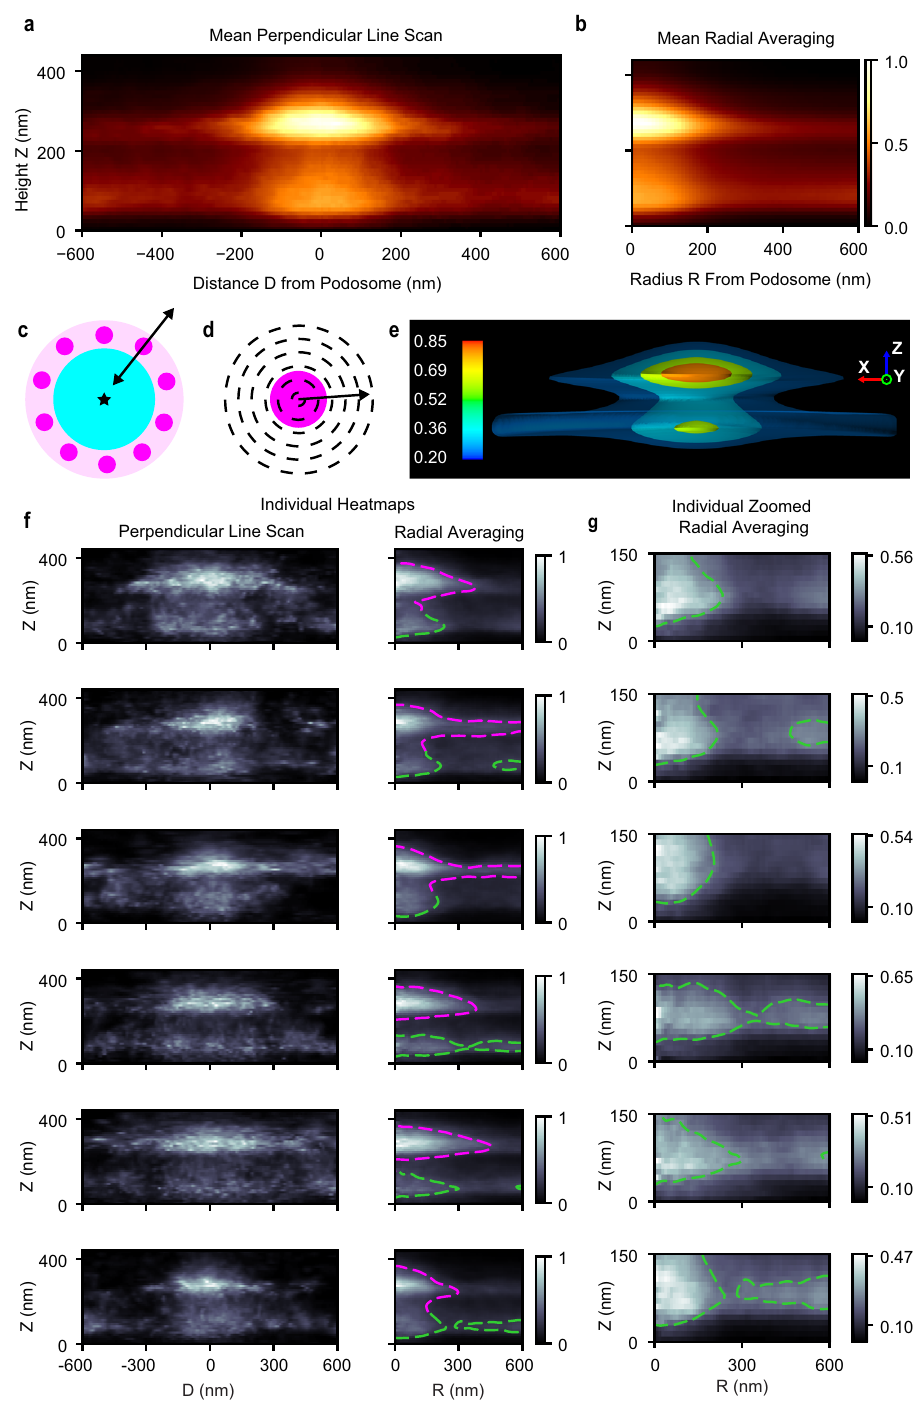
Fig.4|Podosomevisualizationsreveal3Dnanoarchitecture.a , b Meanheatmap for n =72 podosomes from one cell using either ( a ) perpendicular line scan (negative D is inward toward the center of the phagocytosis site, positive is out- ward) or ( b ) radial averaging. Color scale shows normalized mean intensity (arb. units). c , d Schematicrepresentationsforanalysesperformed.Aperpendicularline scan,asshownin c isorientedtowardthecenterofthephagocytosissite,andscans through a podosome perpendicular to the circle of podosomes. Radial averaging, as shown in d only depends on the podosome location. e Three-dimensional